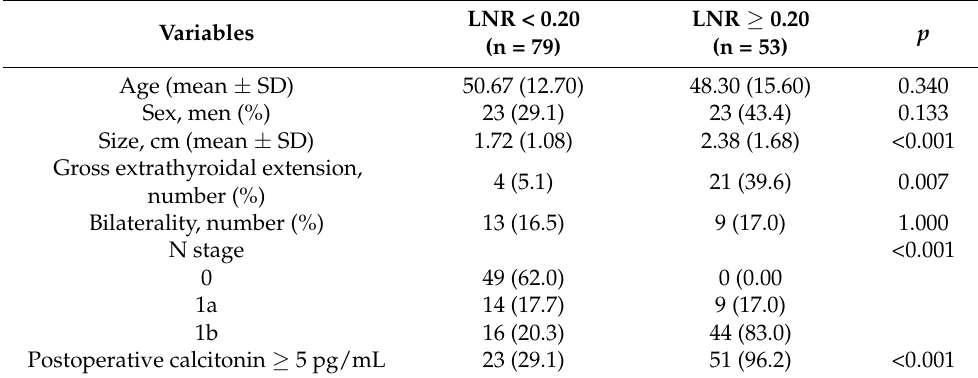
Table 7. Baseline characteristics according to lymph node ratio group.